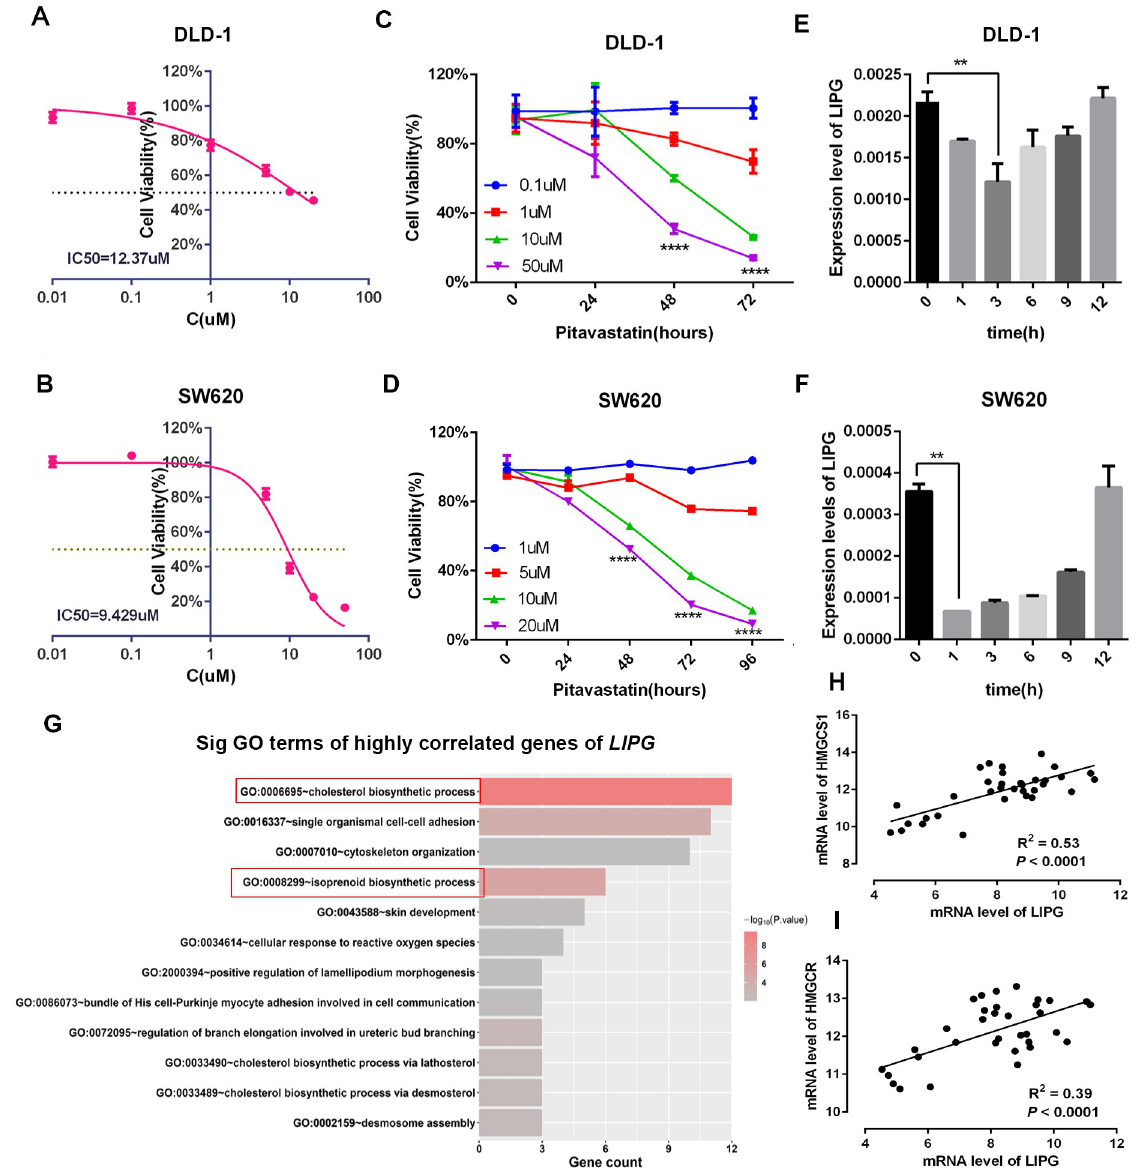
Fig 6. Effect of pitavastatin on CRC cell viability and LIPG mRNA expression. ( A, B ) IC 50 fitting curve for pitavastatin applied to DLD-1 and SW620 cells at 48 h. ( C, D ) Effect of pitavastatin on cell viability of DLD-1 and SW620. ( E, F ) Effect of pitavastatin treatment on LIPG mRNA levels in DLD-1 and SW620 cells. Error bars, SD; two-tailed Student’s t tests. ( G ) Top enriched biological process terms related to LIPG identified via gene ontology enrichment analysis of the highly correlated genes of LIPG based on DAVID online tools ( P < 0.01). ( H, I ) The correlations between the mRNA levels of LIPG and those of HMGCS1 (H) or HMGCR (I) in 34 CRC cell lines (GSE97023). �� P < 0.01, ���� P <